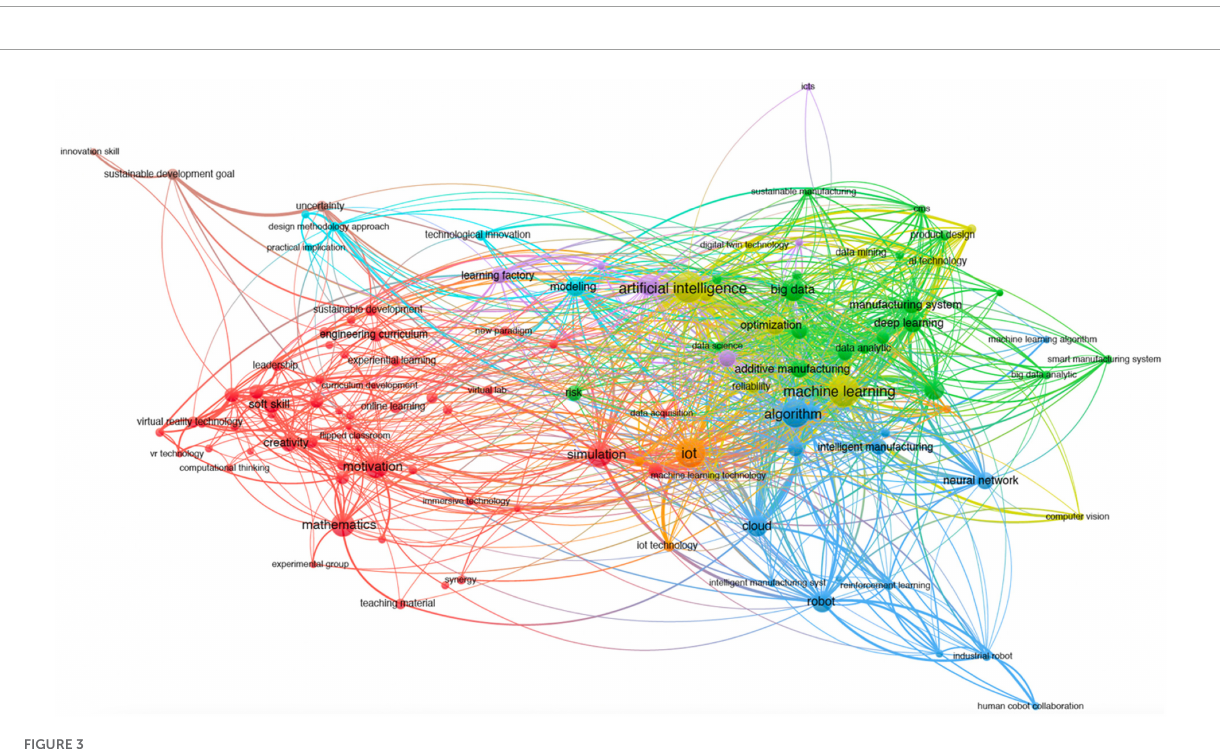
Figure 6 groups these keywords by relevance index into the